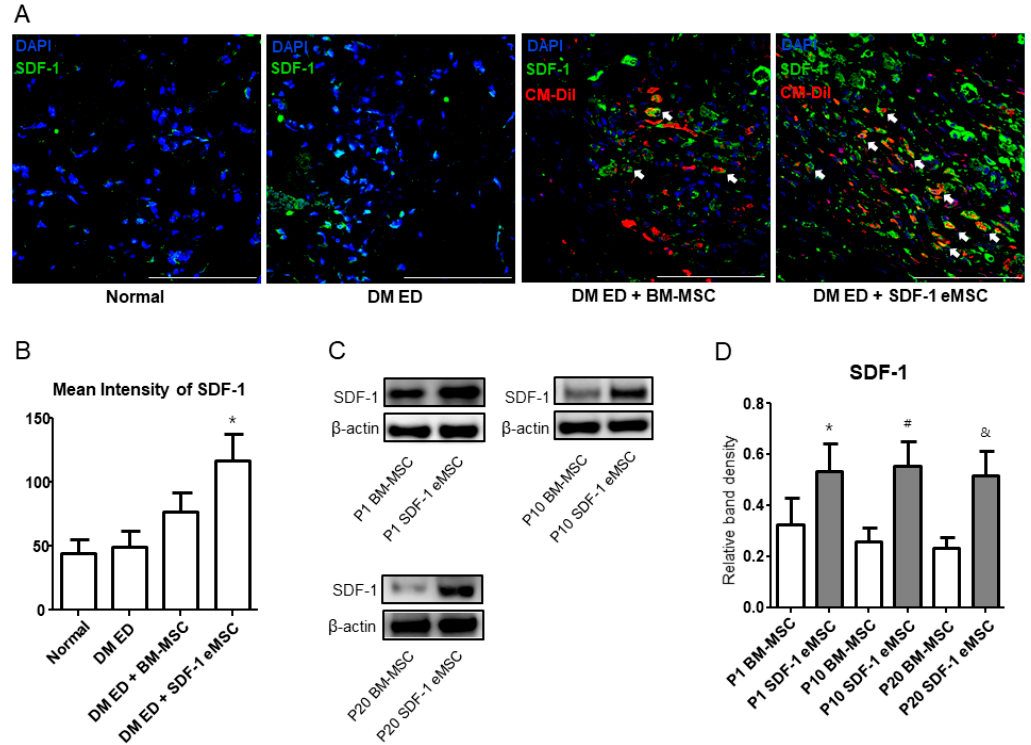
Figure 5. Representative images of SDF-1 expression in vivo and in vitro. ( A ) Representative images of SDF-1 expression in the corpus cavernosum. CM-DiI-labeled MSCs are stained in red and green represents SDF-1. Cell nuclei are stained blue with 4,6-diamidino-2-phenylindole. Arrow indicates SDF-1 released by MSCs. Scale bar: 100 µ m. Original magnification: × 200; ( B ) Mean intensity of SDF-1 expression; ( C ) SDF-1 expression after each passage of BM-MSCs in vitro; ( D ) Relative density of bands in the western blot analysis for each group. Each bar shows the mean value (standard deviation). * p < 0.05 compared with passage 1 BM-MSCs, # p < 0.05 compared with passage 10 BM-MSCs, and & p < 0.05 compared with passage 20 BM-MSCs.